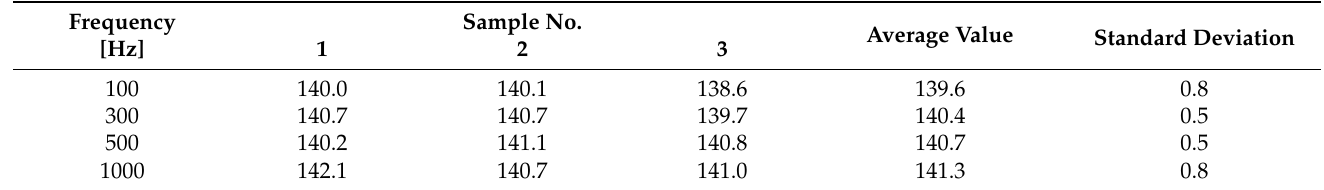
Table 3. Dynamic stiffness (dB re. 1 N/m) for PSMA5 poroelastic pavement with SMA11 as binder course—measurements in situ (S).